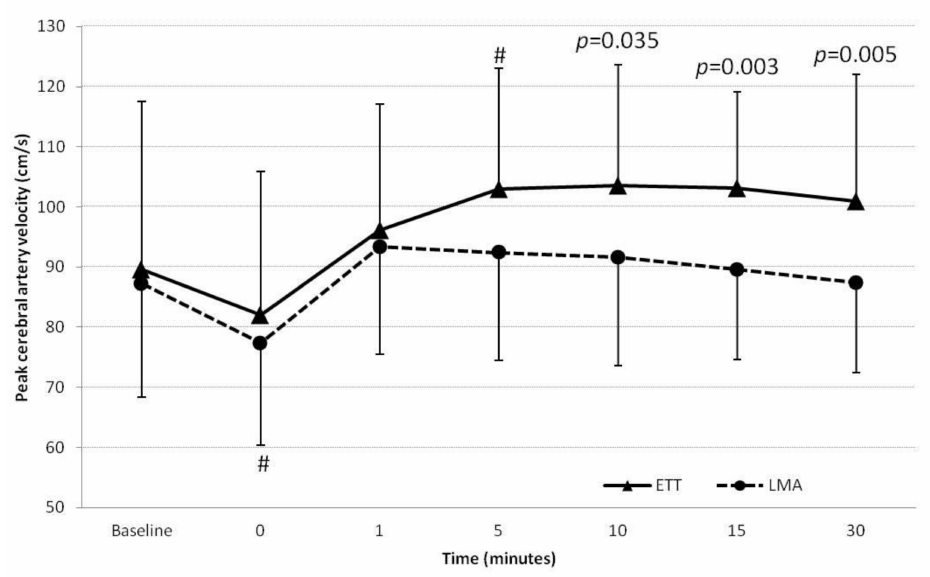
Figure 3. Changes in peak median cerebral artery (MCA) flow velocity (cm s − 1 ) in patients in the endotracheal tube (ETT) and laryngeal mask airway (LMA) groups. ( # p < 0.05 with respect to baseline). Time 0 was the end of surgery, before